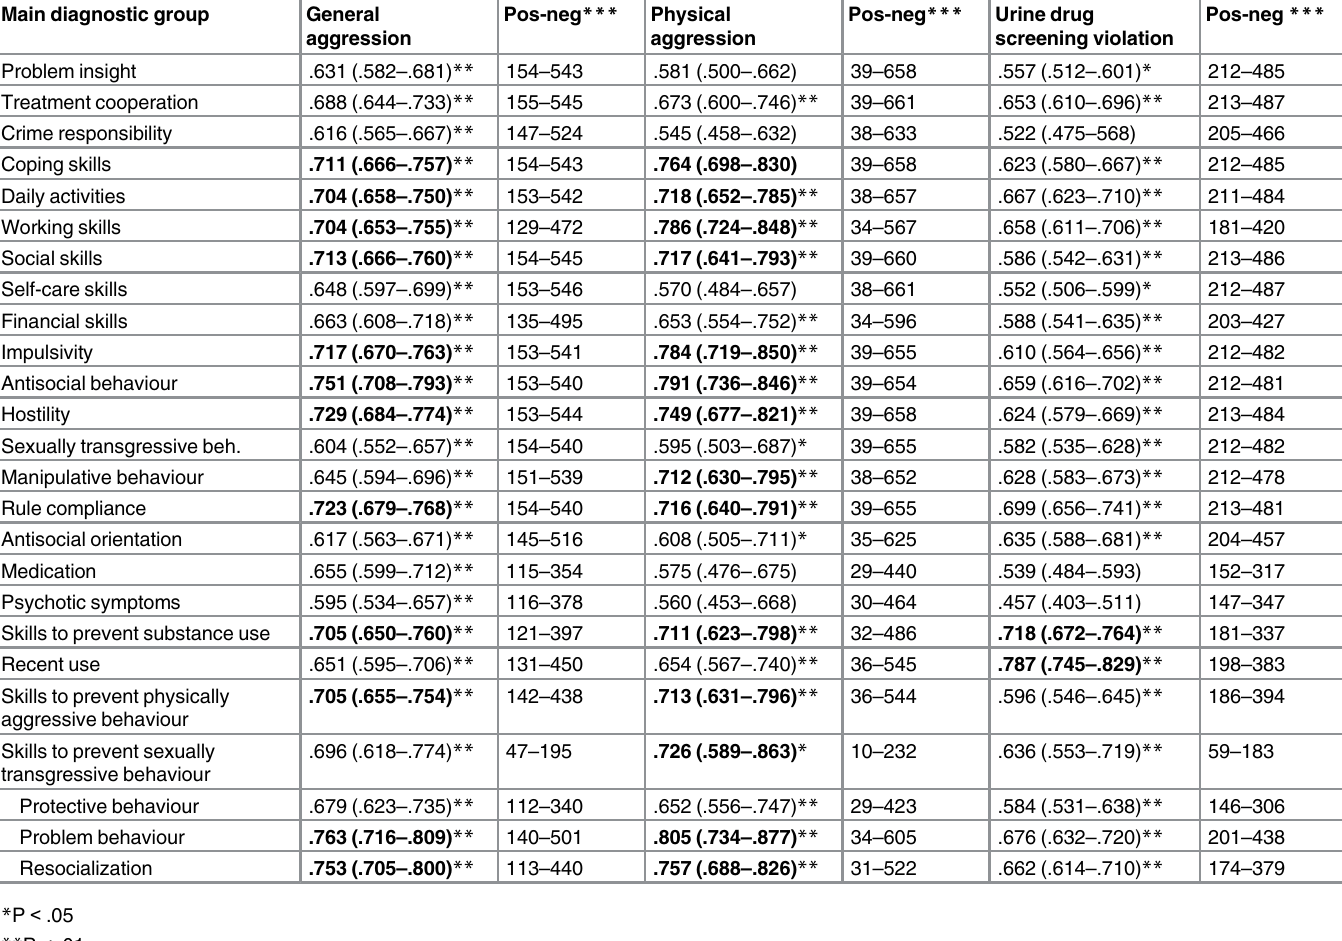
Table 4. AUCs for the main diagnostic